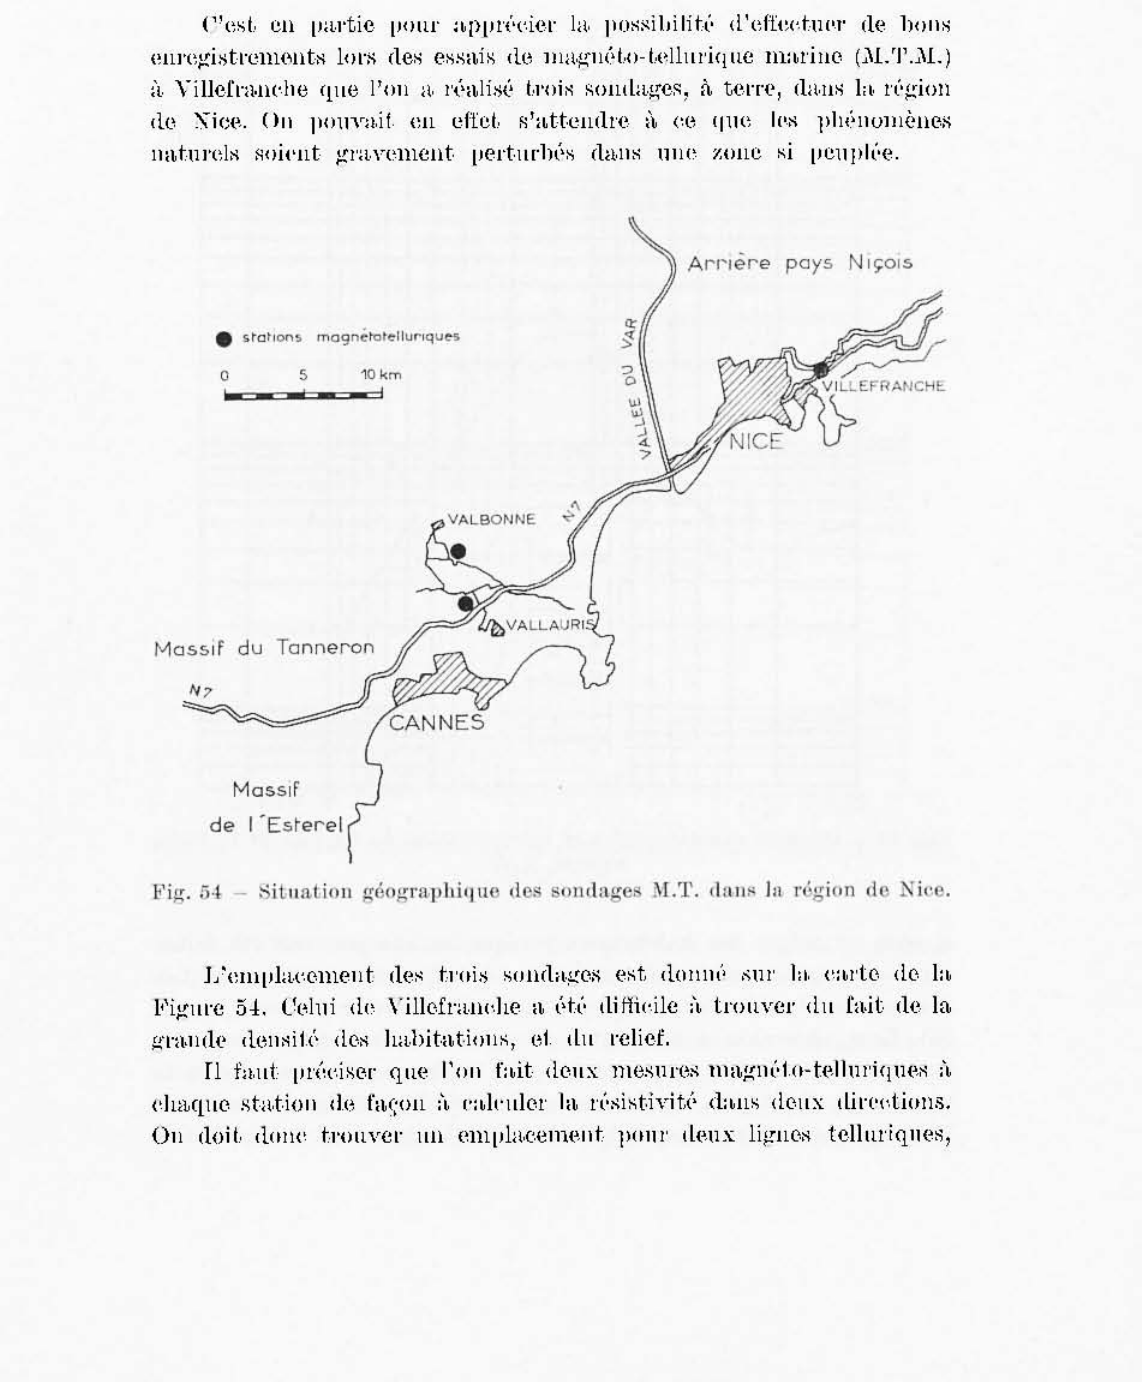
Fig-. 5·] _ .-;itllaiiull géograpld'l\lo dei> s(}ndage~ M.T. d:lll~ la r;;giu!l do Ni,·o.